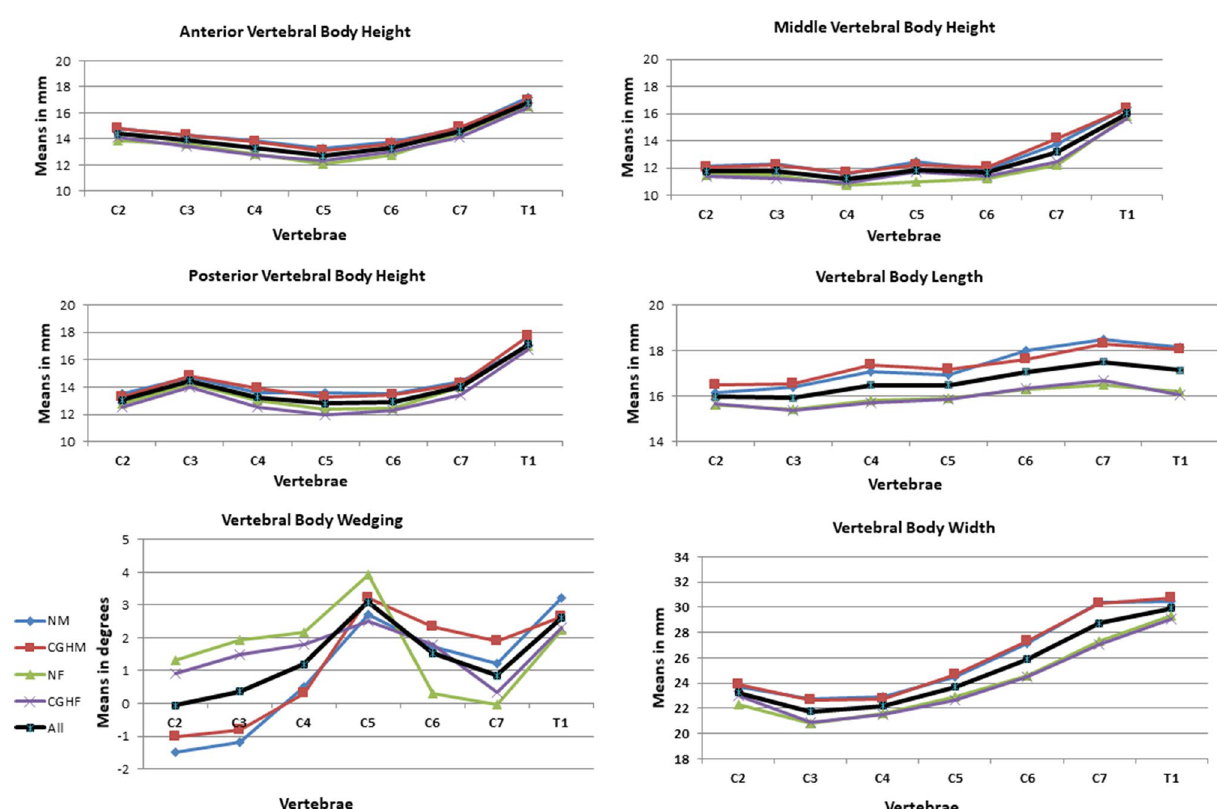
Figure 2. Vertebral body shape variation along the cervical spine. NM normal males, CEHM cervicogenic headaches males, NF Normal females, CEHF cervicogenic headaches females, All all individuals